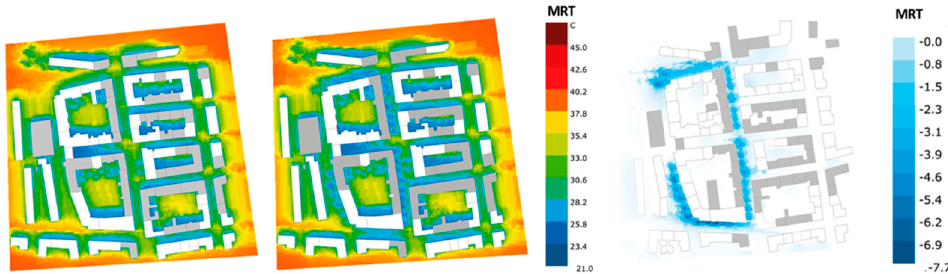
Figure 12. Twenty-four-hour MRT at street level for the smaller sample area with densification ( left ), densification and added trees at street level ( middle ), and the differences at street level between densification scenario without and with trees ( right ).